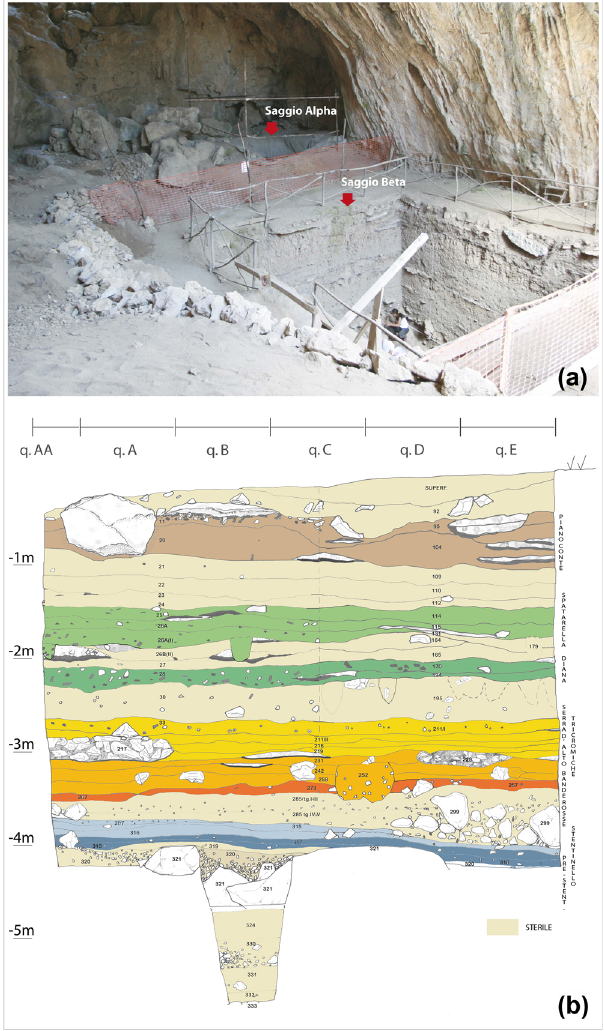
Figure 2: A view of Saggio Alpha and Saggio Beta ( a ) ; stratigraphy of Saggio Beta ( b ) . Modi fi ed after Tiné and Natali ( 2014 )